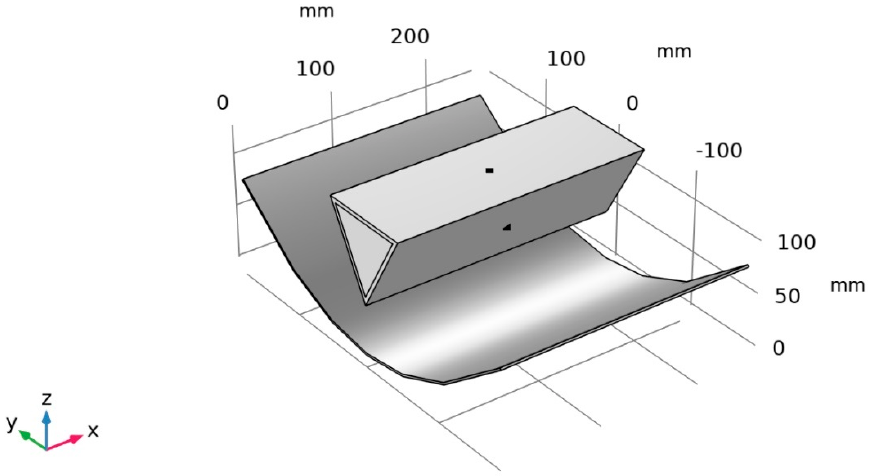
Figure 6. Imported CAD model of thermomechanical SMA actuator within the CFD software.